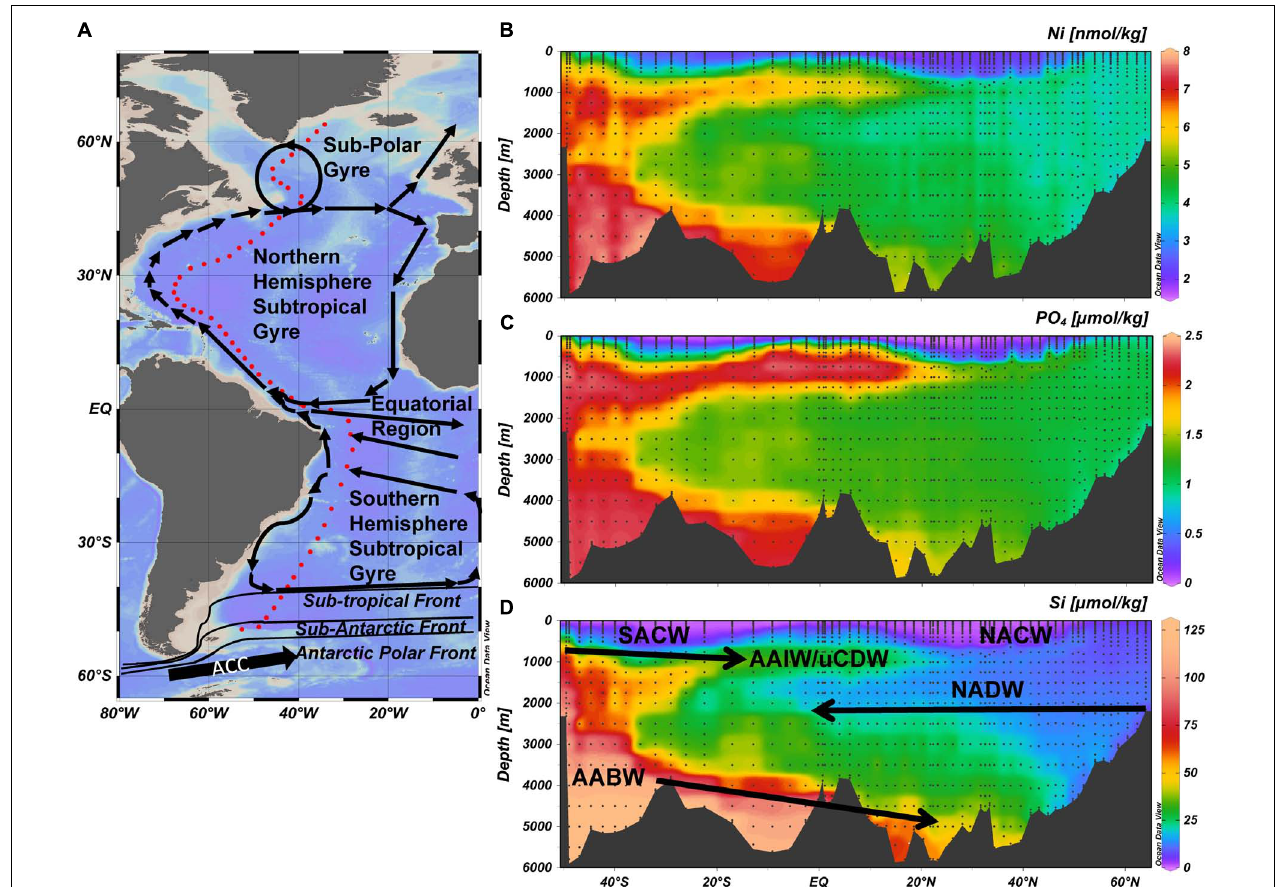
FIGURE 1 | The GEOTRACES GA02 section in the West Atlantic Ocean (A) The 17500 km long GEOTRACES GA02 section in the West Atlantic Ocean based on four cruises and comprising 60 stations (red dots) with 24 sampling depths each; and a general overview of the surface ocean circulation and key oceanographic features. (B) The concentration of dissolved Ni in color scale along the transect. (C) The concentration of dissolved PO 4 in color scale along the transect. (D) The concentration of dissolved Si in color scale along the transect. Note the color scale is not linear for (D) to better visualize the elevated concentrations of Si in AAIW/uCDW. Abbreviations: AABW, Antarctic Bottom Water; AAIW, Antarctic Intermediate Water; NACW, North Atlantic Central Water; NADW, North Atlantic Deep Water; SACW, South Atlantic Deep Water; uCDW, upper circumpolar deep water.